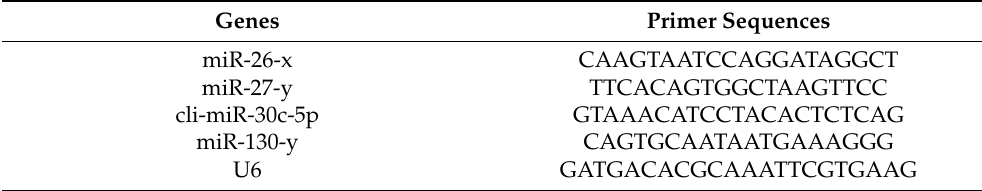
Table 1. Primers for RT-qPCR.